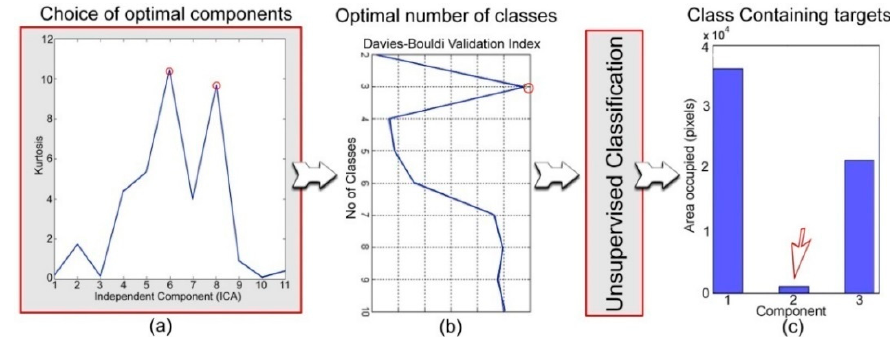
Figure 2. Details of the proposed automatic target detection system concerning: ( a ) choosing the optimal combination of components; ( b ) choosing the optimal number of classes and ( c ) selecting the class that most probably corresponds to seafloor targets.